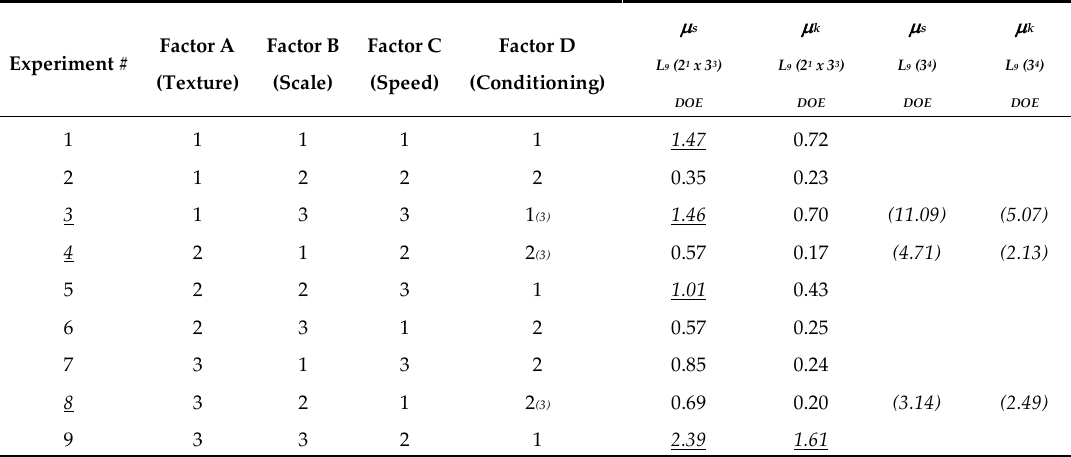
Table 2.  s and  k Results for both experimental designs—L 9 (2 1 x 3 3 ) and L 9 (3 4 ).